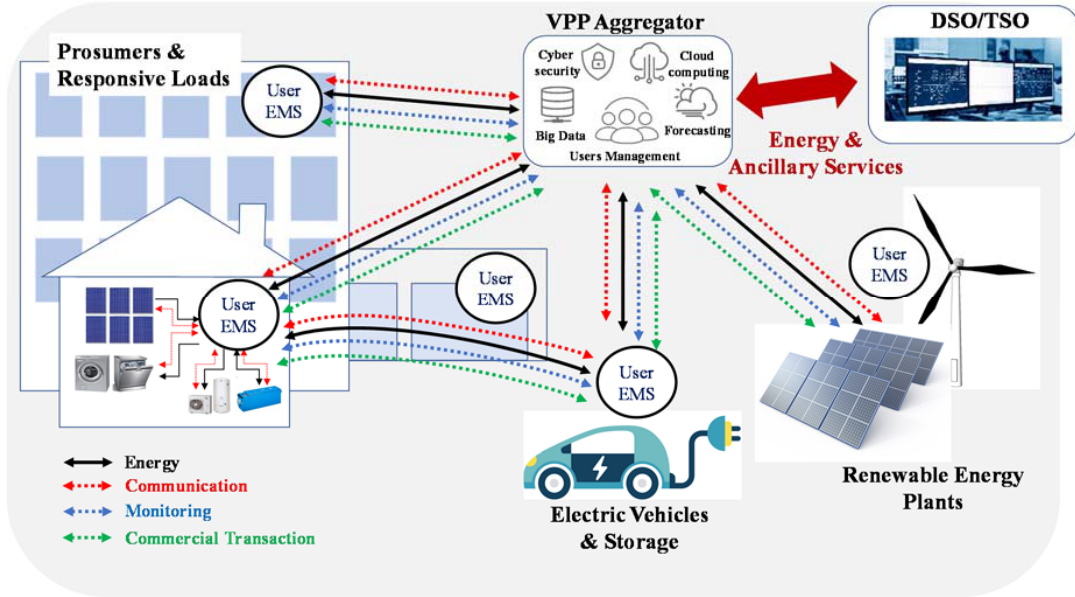
Figure 2. Schematization of a virtual power plant.